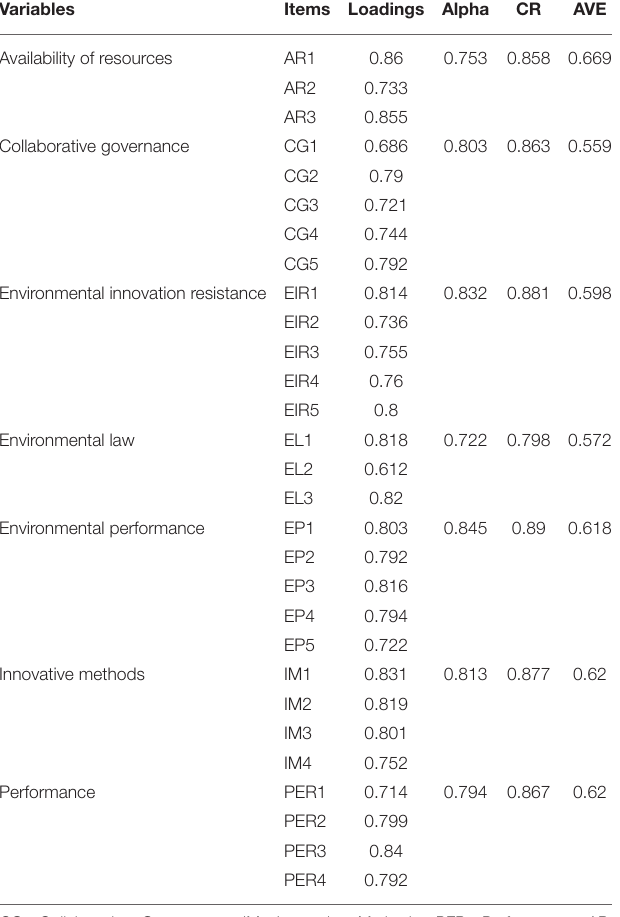
TABLE 2 | Factor loadings and convergent validity.